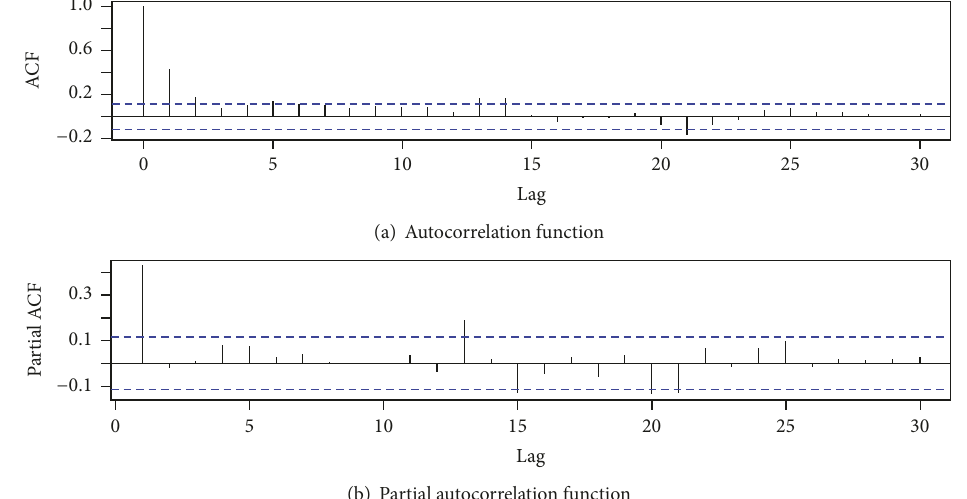
Figure 6: Plot of ACF and PACF in 14 June of Section